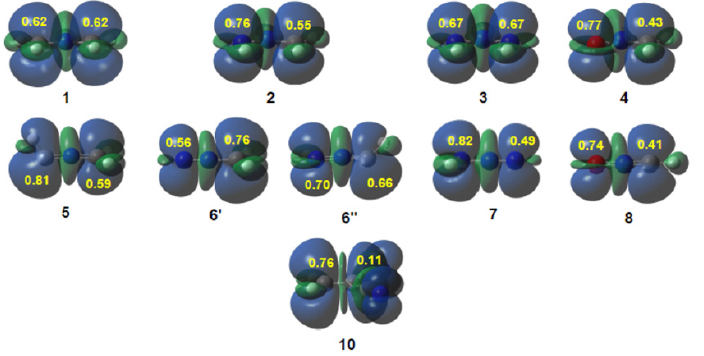
Figure 3. 3D representation of the Mulliken atomic spin density maps of radical cations ( 1–8 ) · + and radical anion 10 · − together with the nucleophilic P − Parr functions of TACs 1–8 and the electrophilic P + Parr functions of DCE 10 .